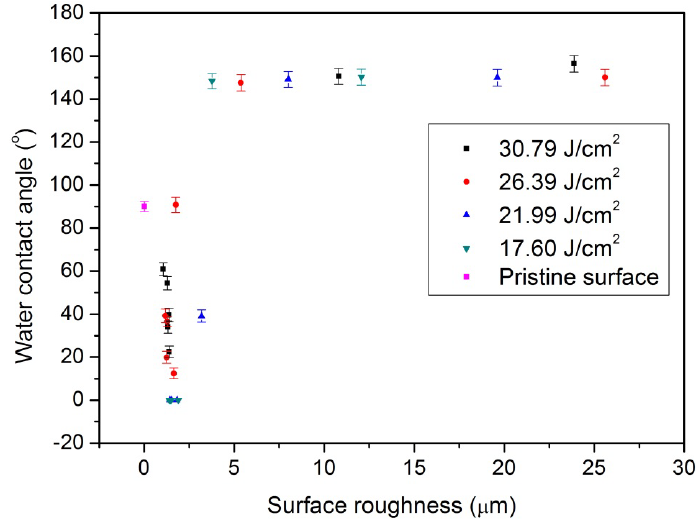
Figure 4. Water contact angle as a function of surface roughness of pristine surface and laser-treated surfaces with various different roughnesses. Here, the laser treatment was conducted at fluences of 30.79 J/cm 2 , 26.39 J/cm 2 , 21.99 J/cm 2 , and 17.60 J/cm 2 with different PDRs from 0.31 W/mm 2 to 6.5 W/mm 2 as shown in Figure